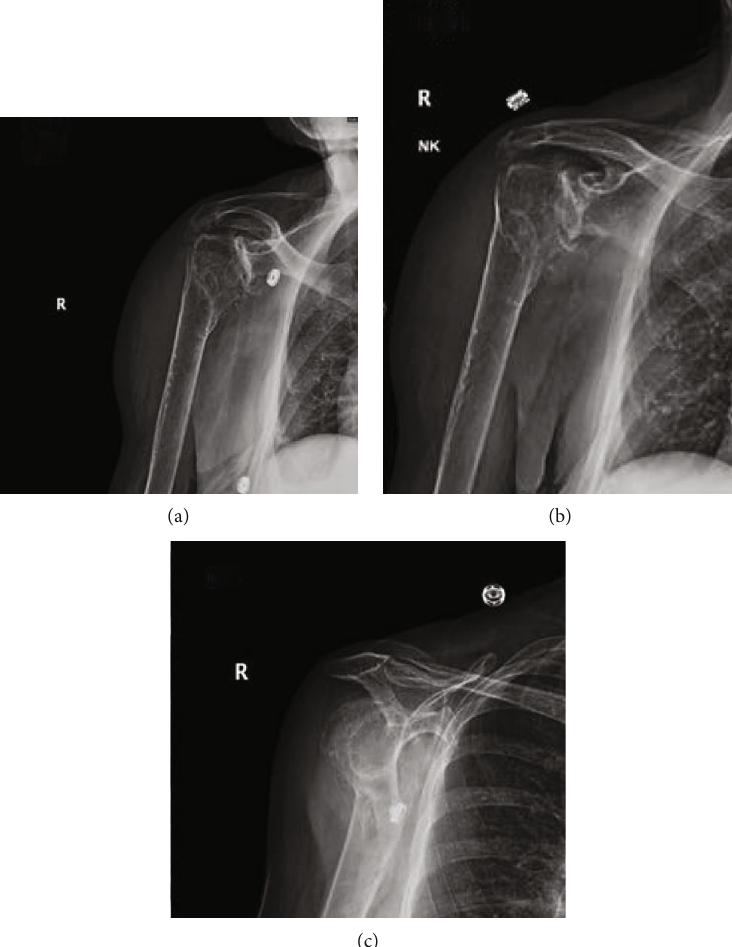
Figure 1: (a – c) Plain radiographs of the right shoulder showing a displaced proximal humerus fracture involving the surgical neck and greater